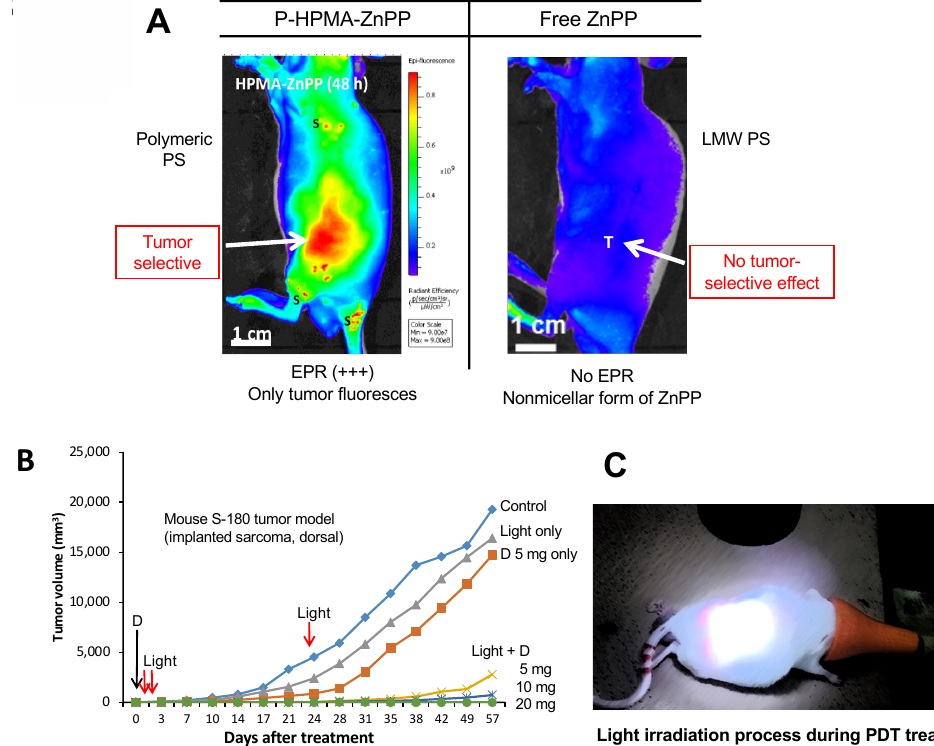
Figure 7. Advantages of EPR-based nano-sized photosensitizers (PSs) for PDT. When a macromolec- ular PS, PZP, was injected iv, intense drug accumulation occurred in the tumor after 24 h, as shown by IVIS fluorescence imaging ( A , left image ). In contrast, the LMW drug free ZnPP did not show any significant tumor drug accumulation ( A , right image ). ( B ) An excellent antitumor effect of PZP was seen in the mouse sarcoma S180 tumor model, especially with endoscopic light irradiation. “D” indicates the drug with iv PZP treatment; red arrows indicate light irradiation. ( C ) Light irradiation process with mouse tumor. Please see refs.